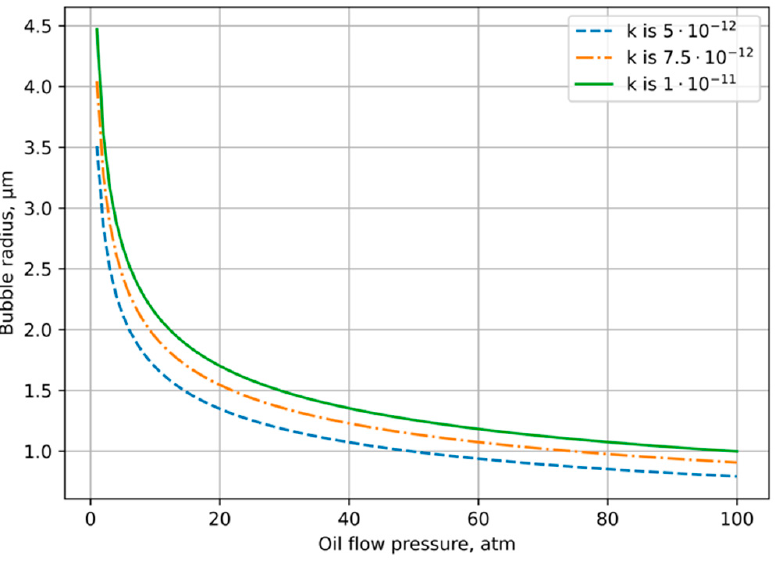
Figure 3. The graph of the radius dependence on the fluid pressure with different k. In addition, in our case, we can neglect the oil degassing effect which manifests itself as gas bubbles floating to the surface of the liquid. Following the studies of [20,21], we shall look for the quasi-equilibrium state of gas bubbles under the Archimedes buoyancy force and resistance force. Restricting by small Reynolds numbers determined for the gas bubbles, the resistance force is given by the Stokes formula F st = − 6 πη R ( ν b − U ) , where η is the dynamic liquid viscosity coefficient, v b is the velocity of the floating bubbles and U